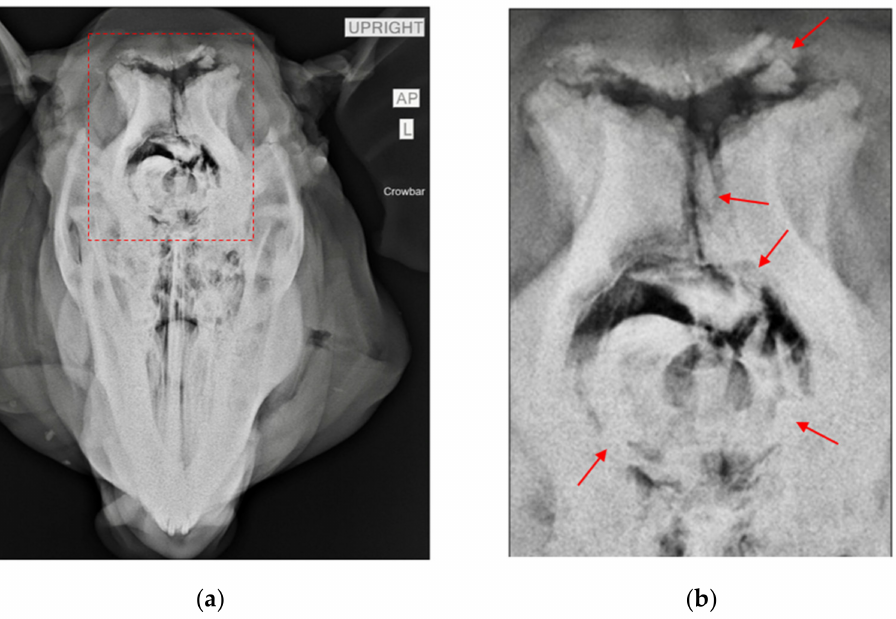
Figure 1. Radiographic image of sample CBH1. ( a ) Pre-burn radiograph of a specimen after manual trauma with a crowbar. Red dotted lines denote the area containing blunt force trauma. ( b ) Close-up image of the area within the red rectangle. Red arrows point to areas of incomplete fractures as a result of blunt force trauma, with associated fragments still